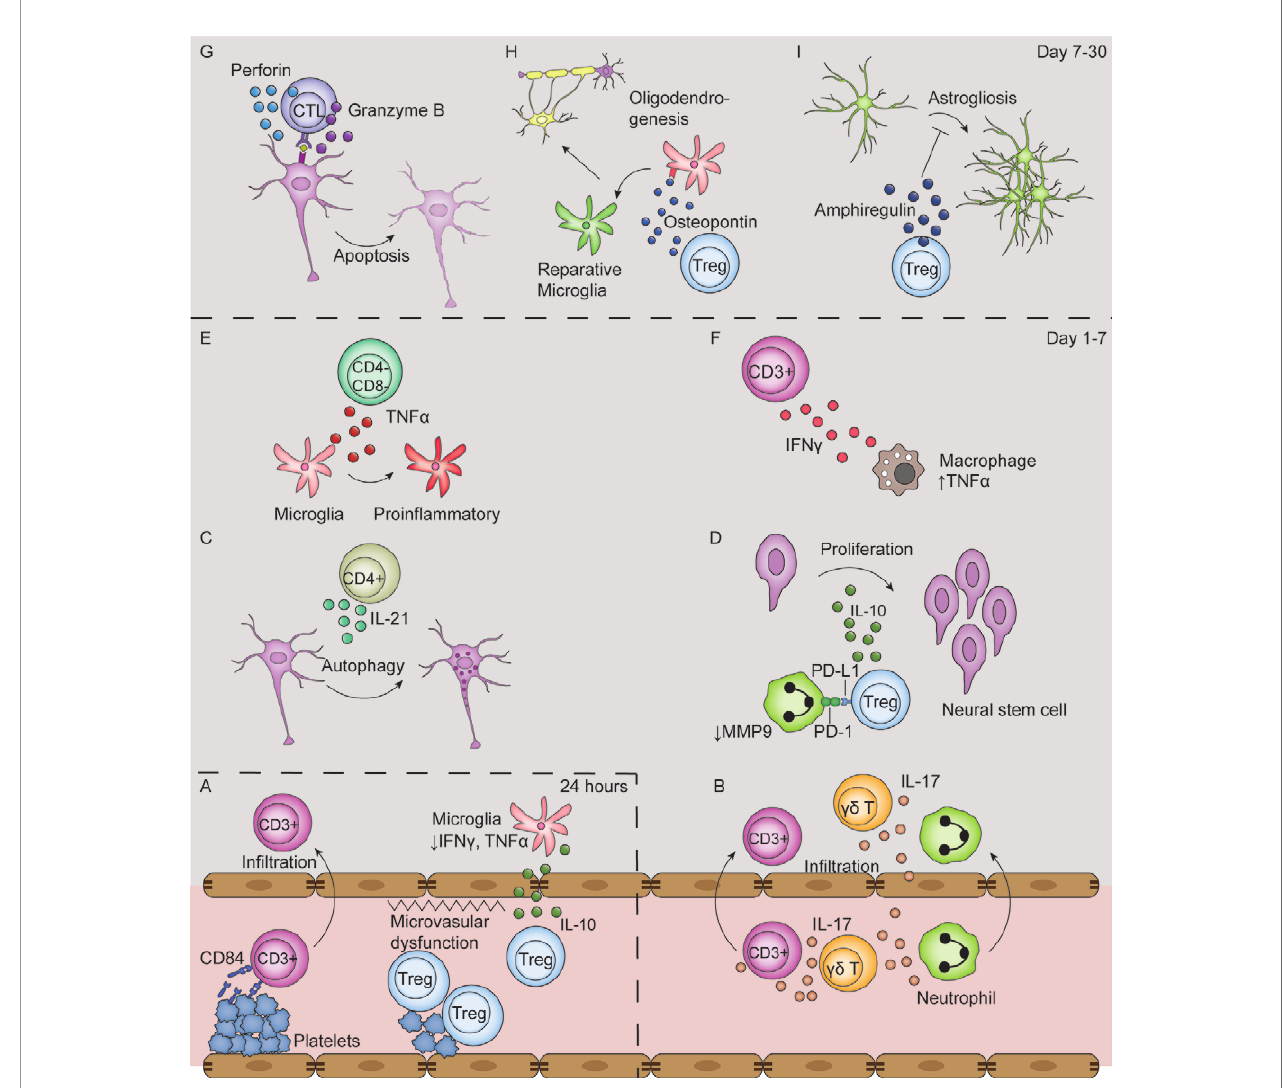
FIGURE 3 | T-cell mediated effects in the ischemic stroke brain. (A) In the fi rst 24 hours after ischemic stroke, Tregs interact with platelets in the vasculature, which induces thrombosis and microvasculature dysfunction. Moreover, Tregs secrete IL-10 to decrease microglial secretion of IFN- g and TNF- a in the absence of their in fi ltration to the parenchyma. Additionally, T cells bind with CD84 shed from platelets and promote their own in fi ltration. (B – F) From day 1 to 7 after ischemic stroke, T cells secrete various types of cytokines, including IL-17 (B) , IL-21 (C) , IL-10 (D) , TNF- a (E) , IFN- g (F) . Moreover, Tregs decrease MMP9 production by neutrophils through PD-L1 and PD-1 interaction (D) . (G – I) From post-stroke day 7 to 30, CTLs induce neuronal apoptosis by perforin and granzyme B secretion in an antigen- dependent way (G) . In addition, Tregs secrete osteopontin to induce a reparative microglia phenotype and therefore promote oligodendrogenesis (H) , and secrete amphiregulin to inhibit deleterious astrogliosis (I)